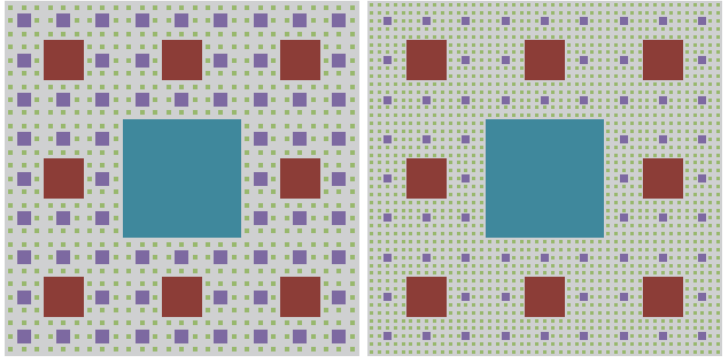
Figure 16. Extensions and variations of the three-tier Sierpinski carpet array [65].